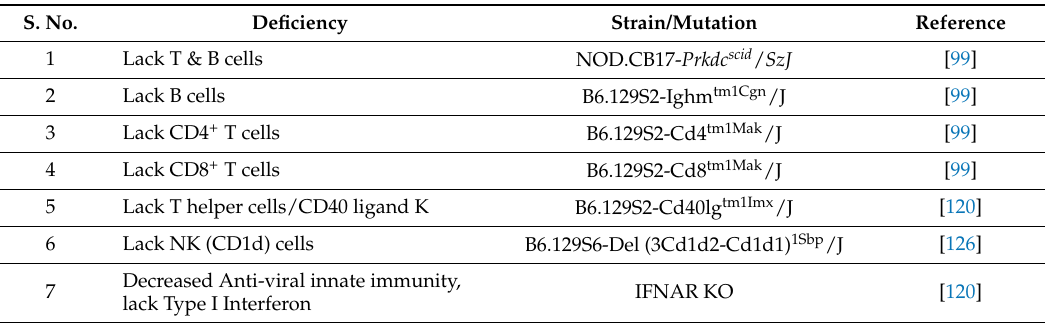
Table 3. List of immunodeficient mice found to be resistant to MmuPV1 skin infections. S. No.